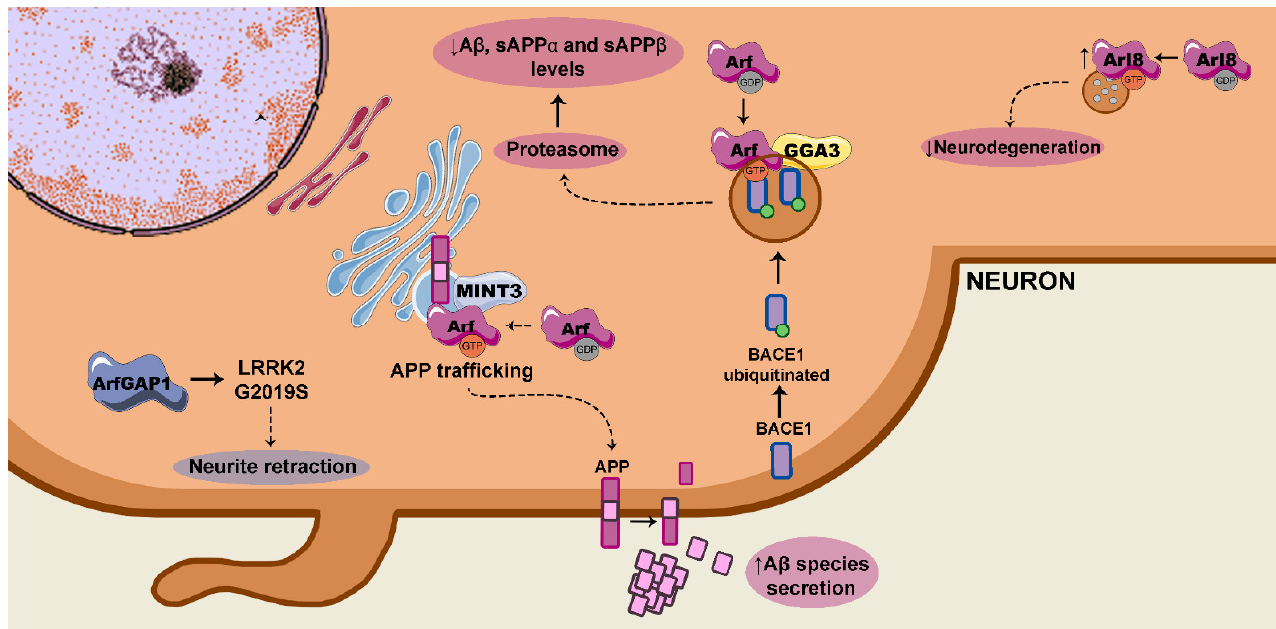
Figure 3. Scheme of the signalling pathways controlled by the small guanosine triphosphatases (GTPases) of the Arf family that are dysregulated in Alzheimer’s disease (AD) (purple) and Parkinson’s disease (PD) (blue). In AD, signalling pathways controlled by Arf are involved in amyloid precursor protein (APP) trafficking to plasma membrane and amyloid-β (Aβ) species secretion. Arf also controls Aβ species levels by favouring the proteasomal degradation of β-site APP cleaving enzyme 1 (BACE1). Arl8 blocks neurodegeneration mediated by Aβ. Regarding PD, ArfGAP1 silencing blocks the neurite retraction induced by LRRK2G2019S. sAPP: soluble APP; GGA3: Golgi-localized γ-ear containing Arf-binding protein 3.